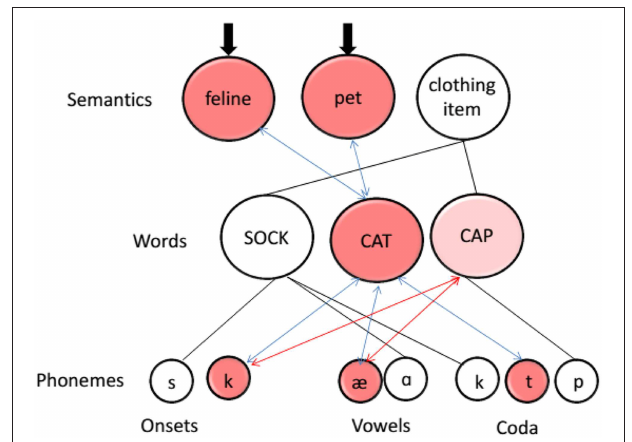
FIGURE 2 | A schematic diagram of the interactive two-step model of language production (Dell and O’Seaghdha, 1992). All connections are bi-directional. Blue arrows indicate connections to the target (“cat”). Red arrows indicate connections that activate the phonological competitor (“cap”). Thick black arrows mark input to the semantic layer of the